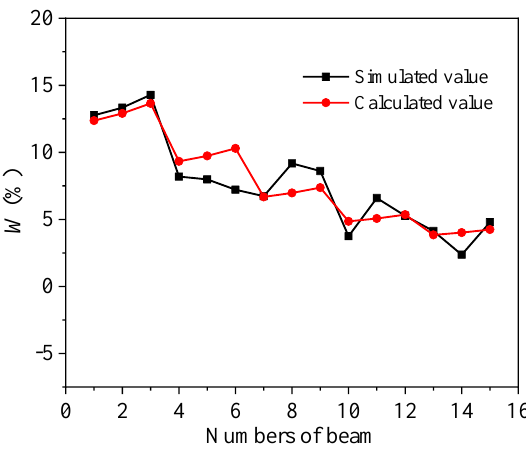
Figure 16. Three-dimensional relationship of W , λ and ρ sv. Equation (1) is applicable to high-temperature beams with a shear span-to-depth ra- tio less than 3.0. The reduction degree of the indirectly loaded RC beam in Table 3 was calculated using Equation (1), and the comparison between the calculated value and the simulated value is shown in Figure 17. It can be seen from Figure 17 that the simulated value of the indirectly loaded beam after experiencing a high temperature was in good agreement with the calculated value of Equation (1).